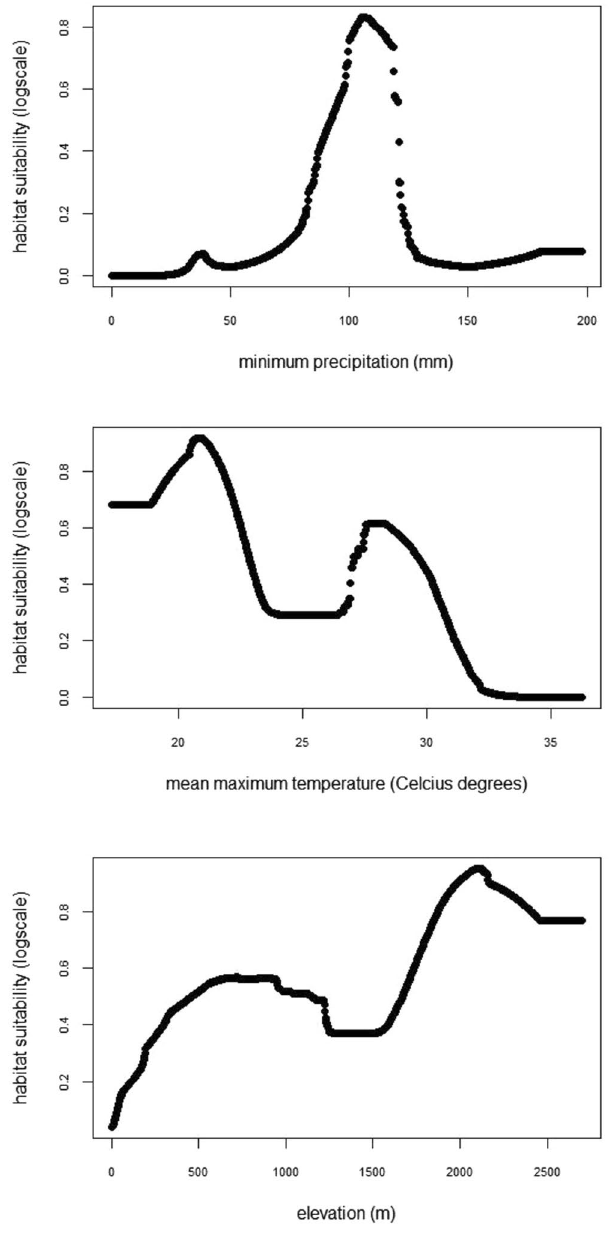
Figure 4. Response curves (average values of 100 models based on adult data only) of the three most significant predictors of habitat suitability for Eleonora’s falcon during the wintering